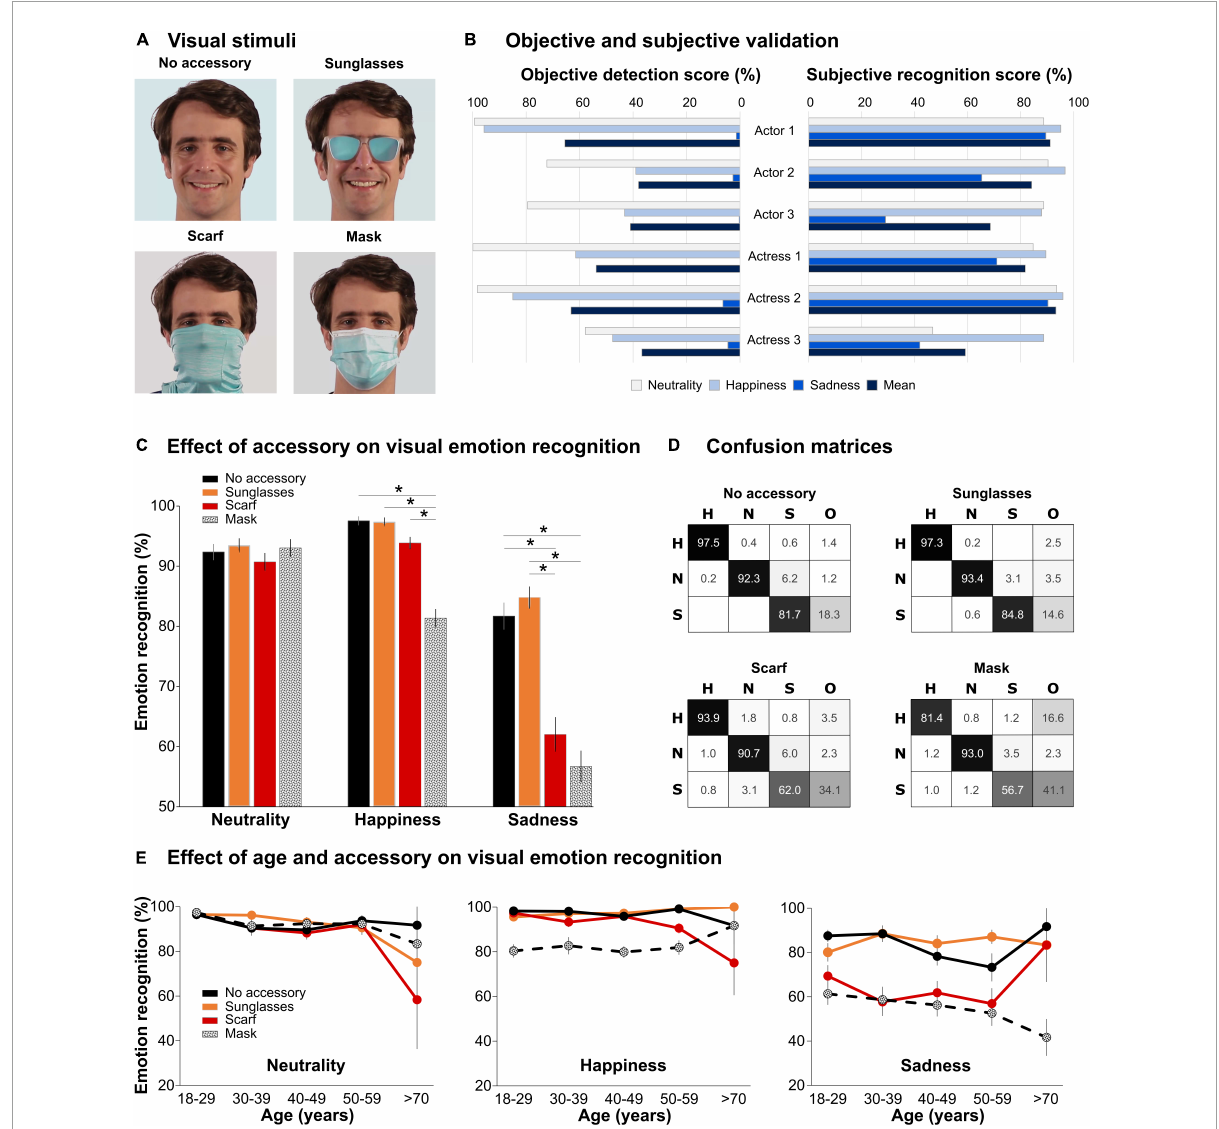
FIGURE1 Effect of facial accessory on visual emotion recognition. (A) Visual stimuli. The four images depict the four accessory conditions (no accessory/sunglasses/scarf/mask) for one actor and one emotion (happiness). The images were extracted from the middle of the video when the emotion was expressed. The color of the background was adjusted, so that the four conditions had the same overall luminosity and colorimetry. (B) Objective and subjective validation. Objective detection scores correspond to FaceReader emotion probability converted in % for the six actors and the three emotions in the no accessory condition. Subjective recognition scores correspond to the mean emotion recognition for the same 18 videos by 124 participants. Videos from Actor 3 and Actress 3 were subsequently removed from the analyses, to evaluate the impact of an accessory only on emotions already correctly categorized. Neutrality is represented in light gray, happiness in light blue, sadness in medium blue, and the mean of the three emotions in dark blue. (C) Effect of accessory on visual emotion recognition. Histograms represent the mean recognition score (in %, ± standard error) for neutrality (left), happiness (middle), and sadness (right), in the four accessory conditions (black: no accessory, orange: sunglasses, red: scarf, and black-and-white pattern: mask). * p < 0.05. (D) Confusion matrices. For each accessory condition, the table presents the mean score (in %) of Happiness (H), Neutral (N), Sadness (S), or Other (O) responses (columns) as a function of the actual emotion in the video (lines: H/N/S). The gray level of each cell is proportional to the score (100%: black and 0%: white). (E) Effect of age and accessory on visual emotion recognition. Mean recognition score (in %, ± standard error) for neutrality (left), happiness (middle), and sadness (right), in the four accessory conditions (same color code as in panel C ) for the five age groups.